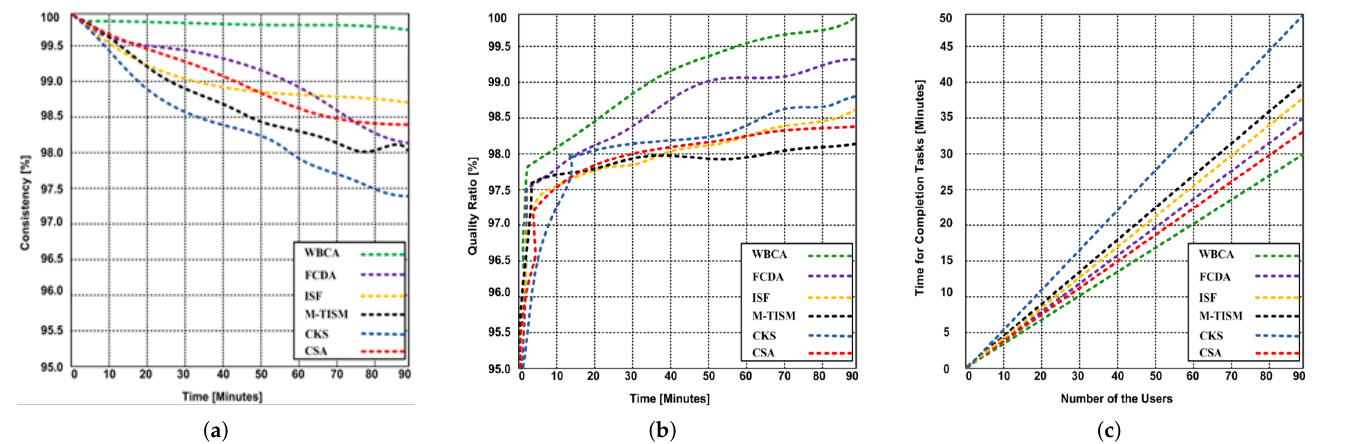
Figure 4. ( a ) Cybersecurity topic consistency using proposed WBCA and contending programs (M-TISM, ISF, FDCA, CSA, and CKS). ( b ) The quality ratios of the advanced cybersecurity topics using proposed WBCA and contending programs (M-TISM, ISF, FDCA, CSA, and CKS). ( c ) The correlation between the number of users and the time consumed when solving basic cybersecurity tasks with the proposed WBCA and contending programs (M-TISM, ISF, FDCA, CSA, and